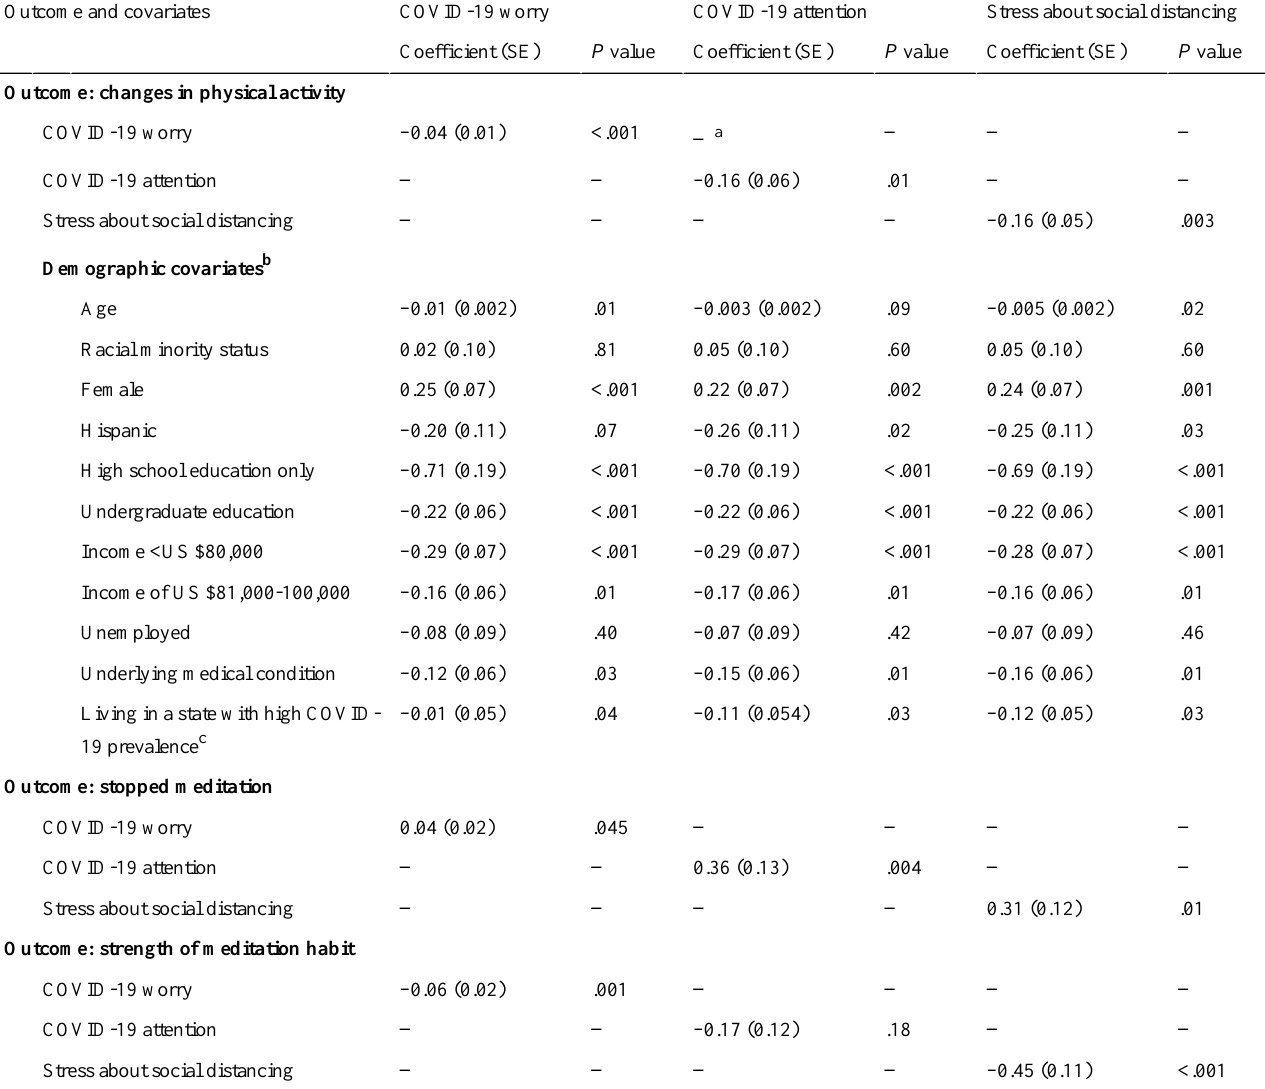
Table 5. Associations between health behavior engagement and COVID-19–related worry, attention to news, and stress. The table presents the coefficients from ordinary least squares regression models for the continuous outcomes, changes in physical activity, and meditation habit strength on COVID-19–related worry, attention to news, and stress, and logistic regression models for the stopped meditation outcome on COVID-19–related worry, attention to news, and stress. Standard errors were estimated using heteroscedasticity-robust